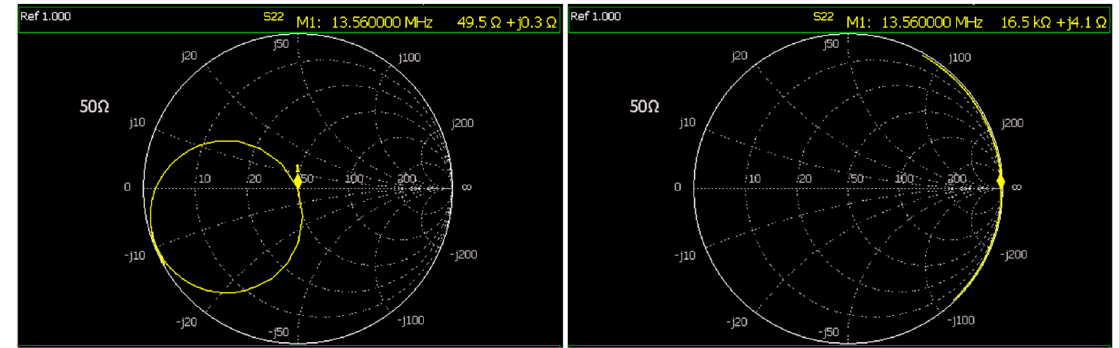
Figure 7. The impedances of (left) the wearable unit’s transmitter coil with the 50 Ω capacitive matching network equal to (49.5 + j0.3) Ω , (right) the impedance of the implantable unit’s receiver coil resonant LC network equal to (16.5 + j0.0041) k Ω , both measured at the RFID carrier frequency of 13.56 MHz.